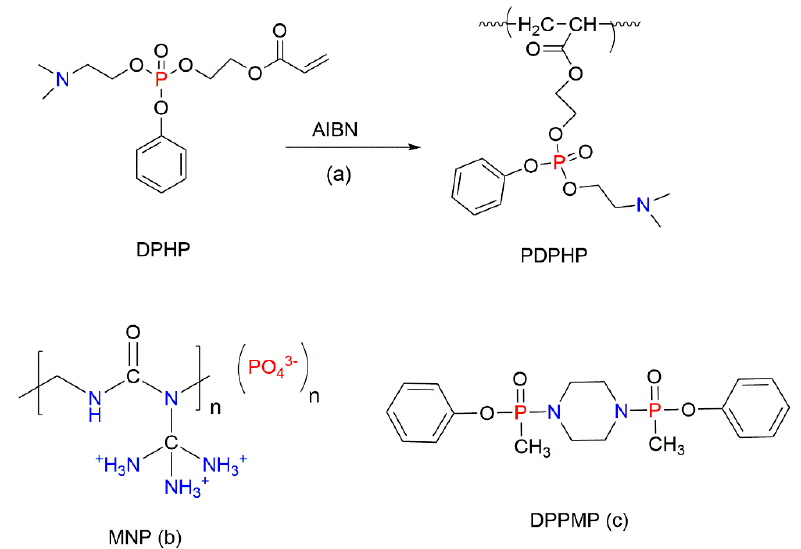
Figure 15. Synthesis of PDPHP oligomer ( a ), chemical structures of macromolecular P–N-based FR, (MNP) ( b ) and diphenyl piperazine-1,4-di-ylbis(methylphosphinate) (DPPMP) ( c ) [92–94]. PDPHP: oligomer of 2-dimethylaminoethylphenylhydroxyethylacrylate phosphate.